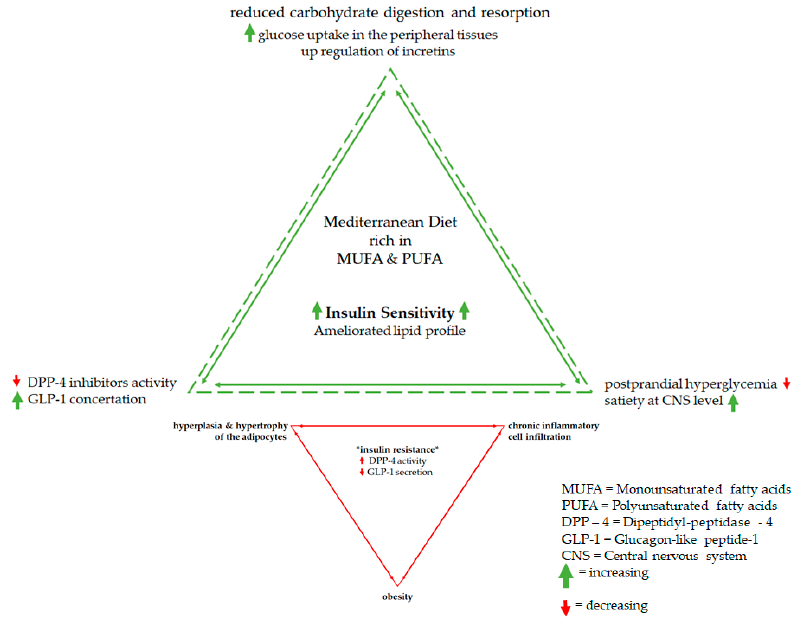
Figure 4. Mediterranean diet vs. Insulin resistance, possible mechanisms.